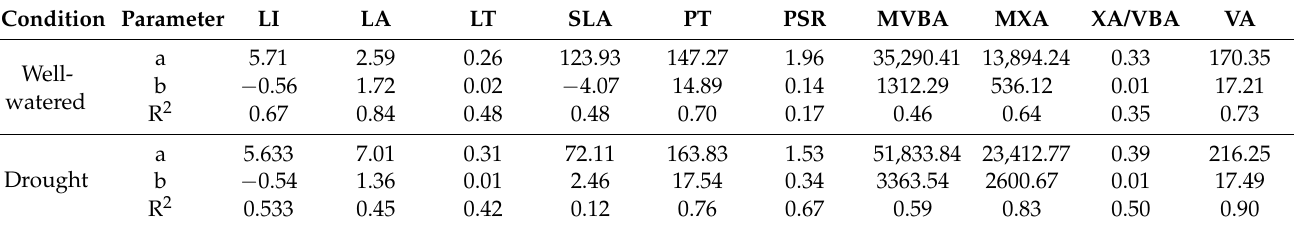
Table 2. Regression analysis of heteromorphic leaf morphology and anatomical structure and tree height under different soil moisture